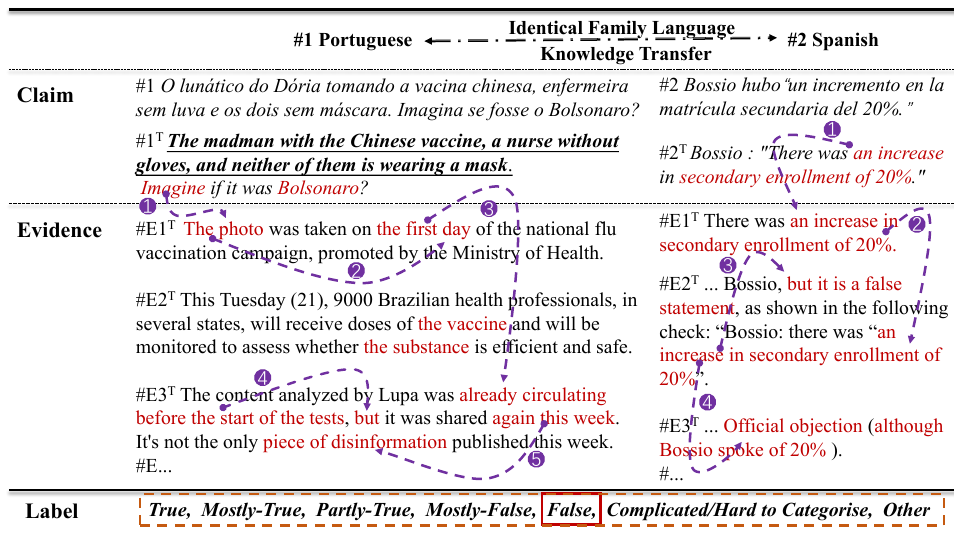
Figure 1. Typical Examples from X-FACT. Example #1 and #2 are from Portuguese and Spanish, respectively. Every sample consists of a claim, evidence, and label. Due to the lack of space, the original claims are only shown in the figure, and the translations (symbol # T ) of claims and parts of evidence are offered as the central part to better illustrate the